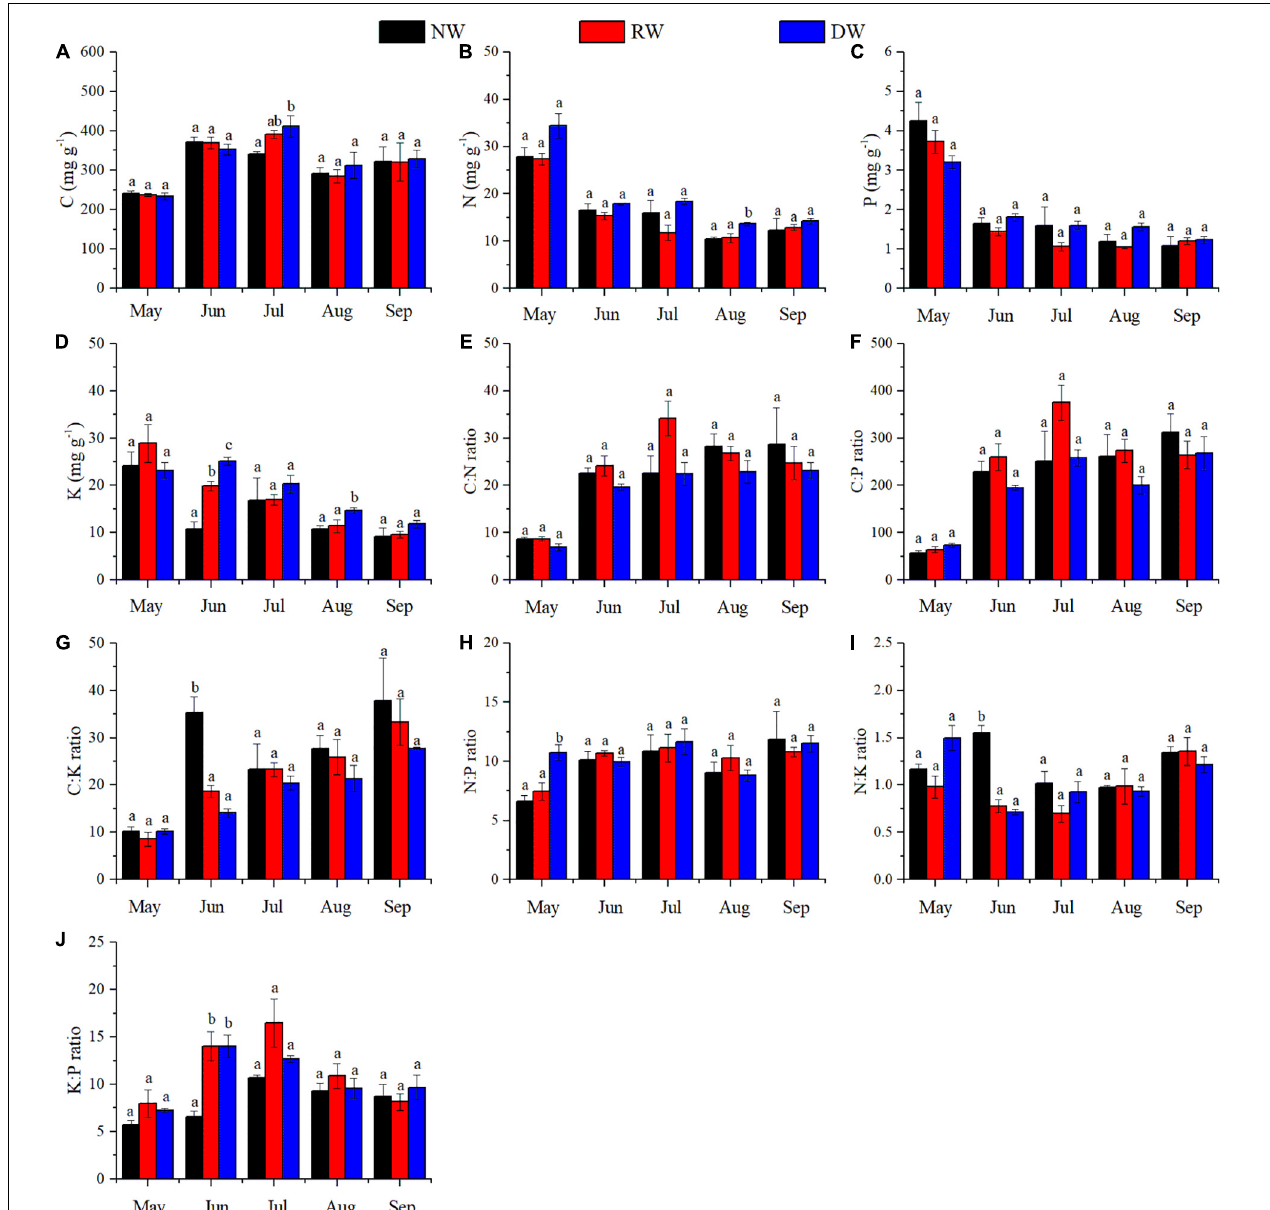
FIGURE 3 | Effect of wetland restoration and degradation on C, N, P, and K stoichiometry of Carex schmidtii at the entire growth stages (means ± se, n = 3). (A) C concentration, (B) N concentration, (C) P concentration, (D) K concentration, (E) C:N ratio, (F) C:P ratio, (G) C:K ratio, (H) N:P ratio, (I) N:K ratio, and (J) K:P ratio. NW, Natural tussock wetland; RW, Restored tussock wetland; DW, Degraded tussock wetland. Different letters stand for significant differences at the 0.05 significance level in NW, RW, and DW in the same growth stage.